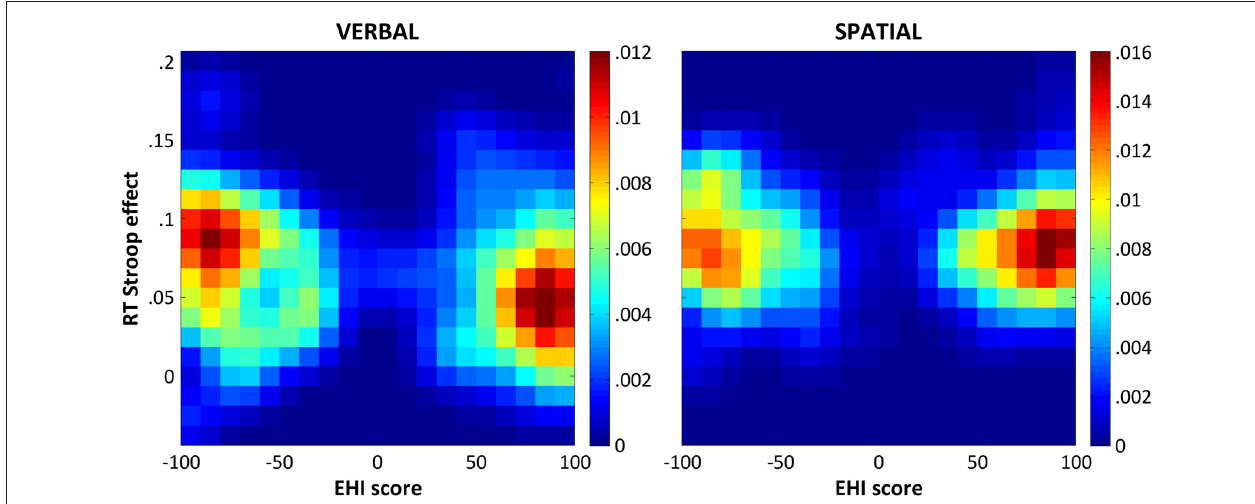
FIGURE 1 | Bivariate distributions of the response time (RT) Stroop effects and the Edinburgh Handedness Inventory (EHI) scores. The figure shows the bivariate distributions of the participants’ verbal (left panel) and spatial (right panel) Stroop effects ( y axis) as a function of their EHI scores ( x axis) as derived from 10,000 random subsets matching the number and the EHI scores of participants with negative and positive EHI scores in our sample (see “Results” section for details). The bivariate distributions were smoothed with a Gaussian kernel with a full-width half-maximum of 2 × 2 bins, which corresponds to a Stroop effect of 0.025 and an EHI score of 10. The colorbars indicate probability